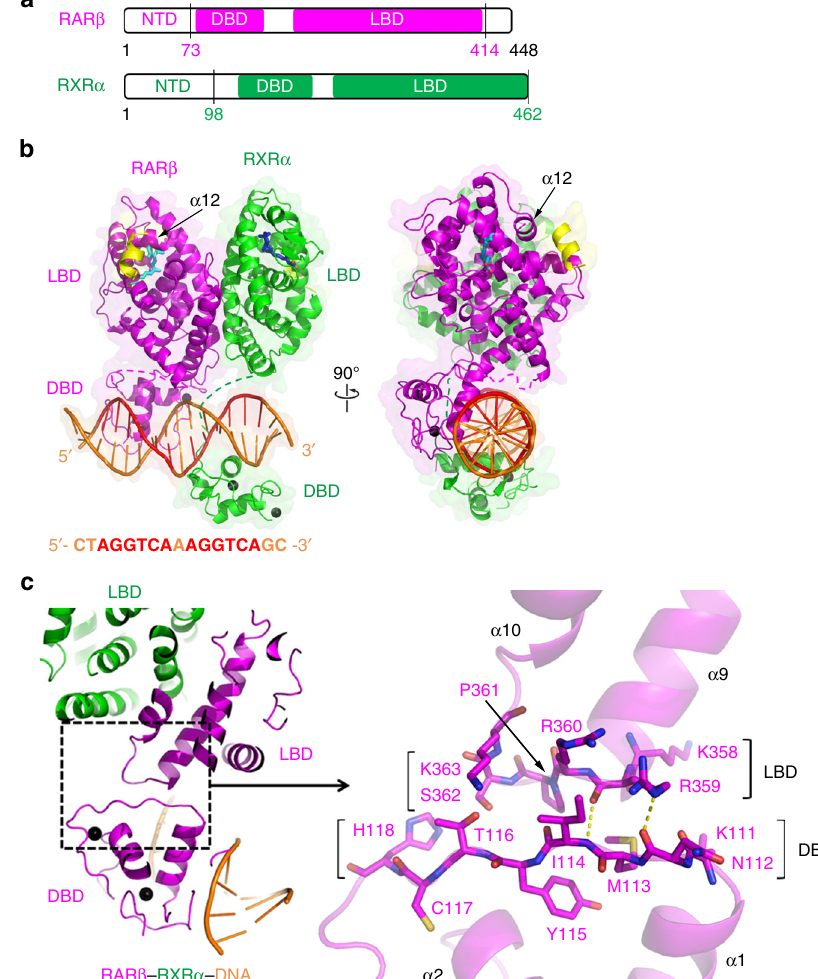
Fig. 1 Overall structure of RAR β – RXR α – DNA complex and the DBD – LBD interface of RAR β . a Schematic representation shows the domain arrangements of RAR β and RXR α , with the residue numbers labeled for the protein constructs used in crystallization. b Overall structure of the RAR β – RXR α heterodimer on DNA in two views. The disordered hinge regions of RAR β (residues 153 – 173) and RXR α (residues 210 – 225) are shown in dashed lines. The colors used for RAR β , RXR α , DNA, coactivator peptides, REA, 9CR, and Zn are magenta, green, orange, yellow, cyan, blue, and black, respectively. The AGGTCA sites within DR1 DNA sequence are colored in red. The helix-12 ( α 12) of RAR β LBD is also labeled by black arrows. c The DBD – LBD interface within the RAR β protein, together with an enlarged view on the right side showing the participating residues. The two hydrogen bonds (formed by N112 [O] and R359 [NE], and by I114 [N] and R359 [O]) at the interface are shown as yellow